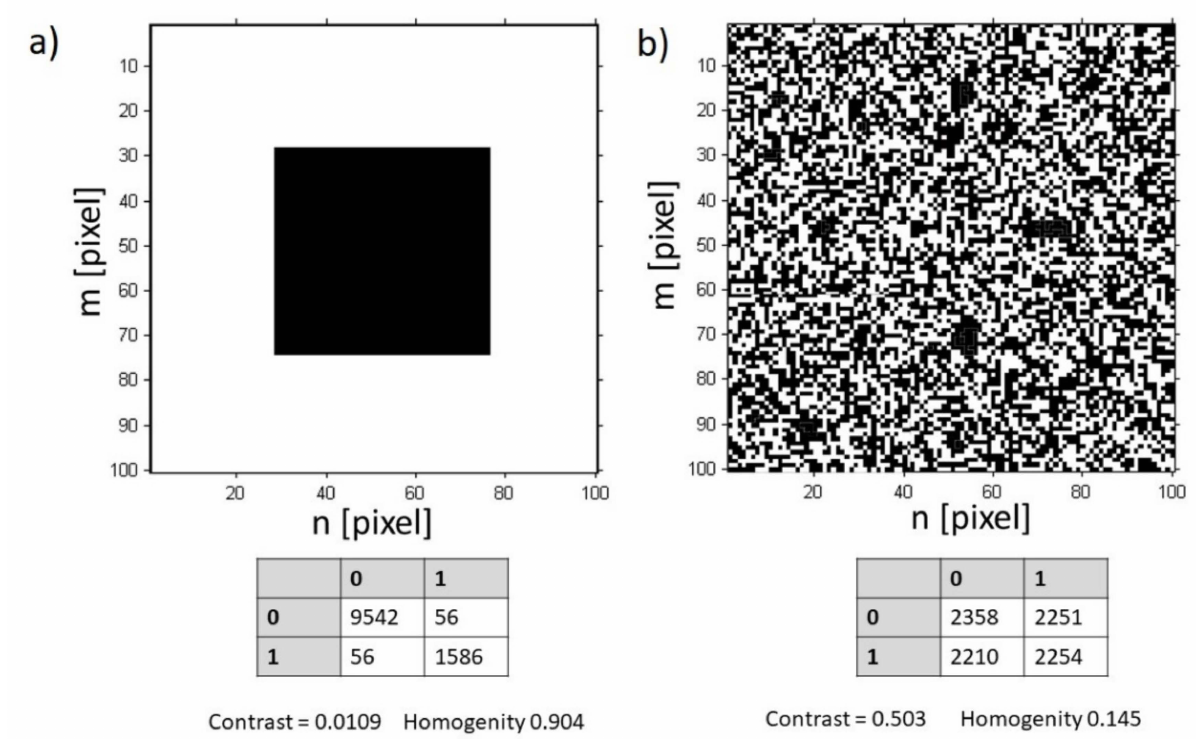
Figure 3. ( a , b ) Artificial images of the different contrast of the GLCM built with the similar number of black “0” and white “1”